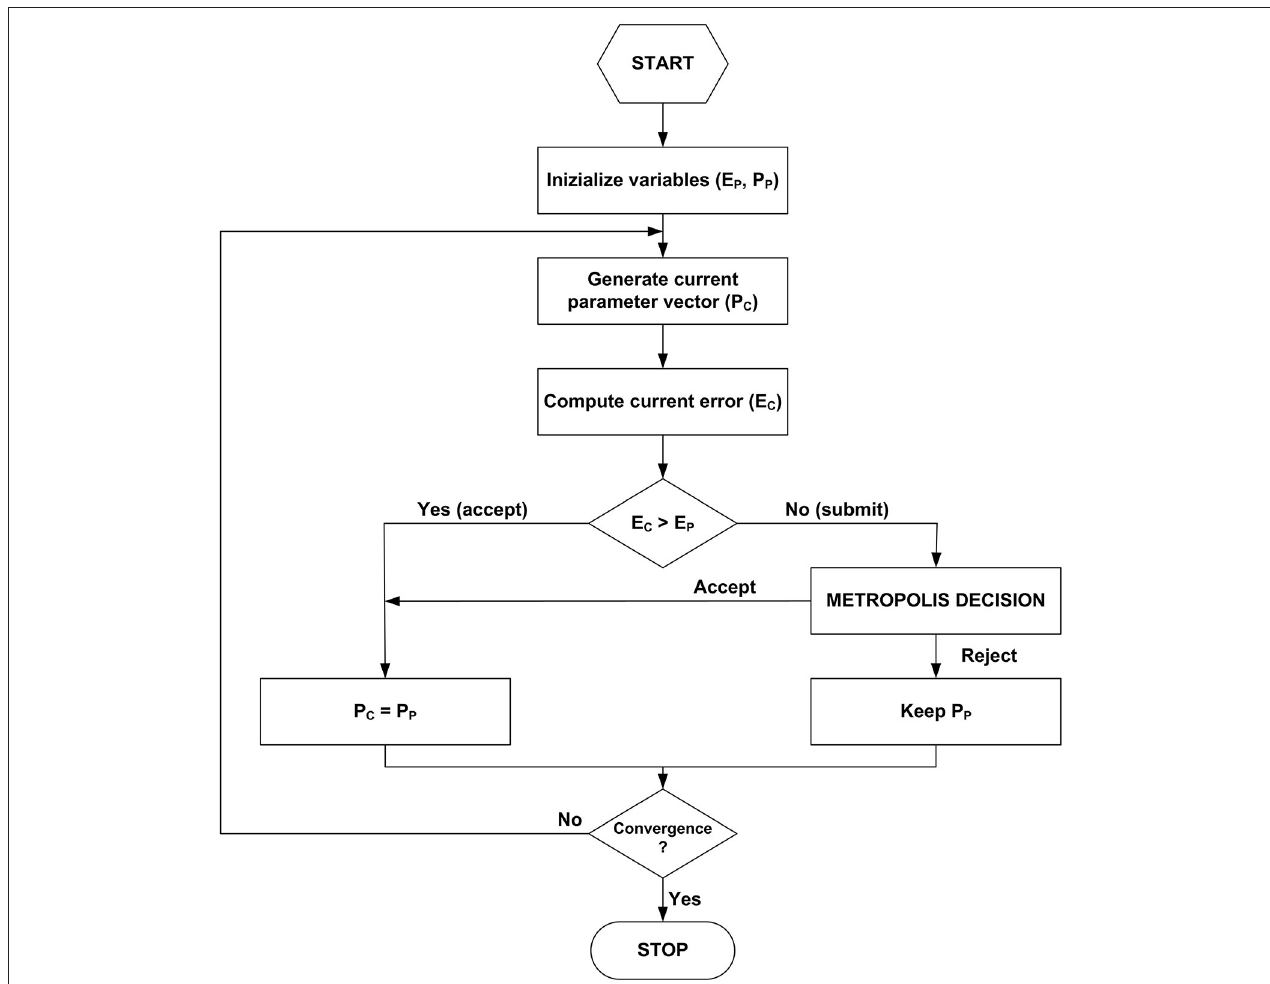
FIGURE 2 | Schematic flowchart of program (A). See the text for